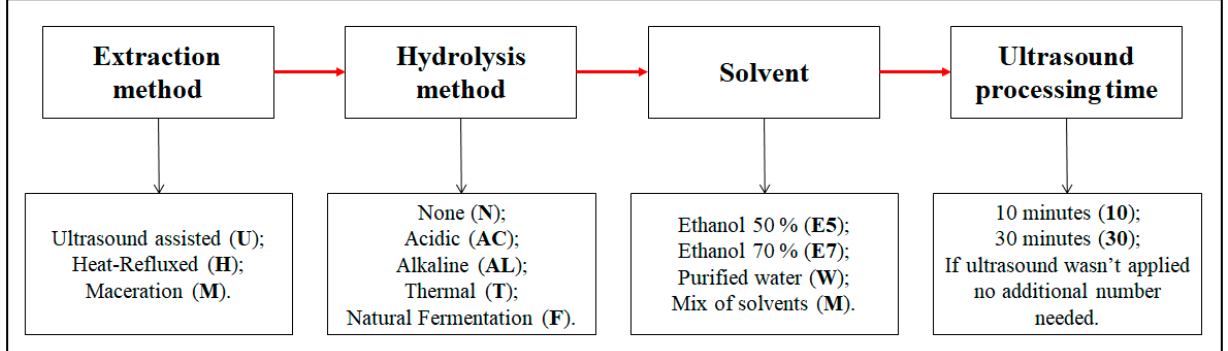
Figure 2. Decoding of the samples provided in Table 1. Table 1. Extraction conditions used for the experiment.